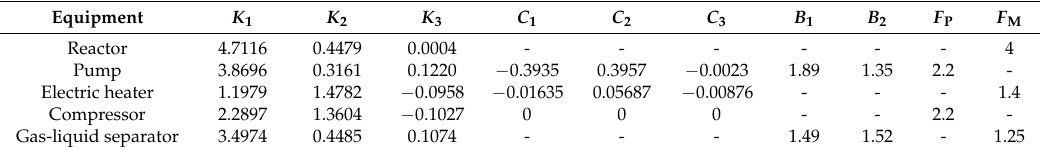
Table 4. The coefficient for each equipment.